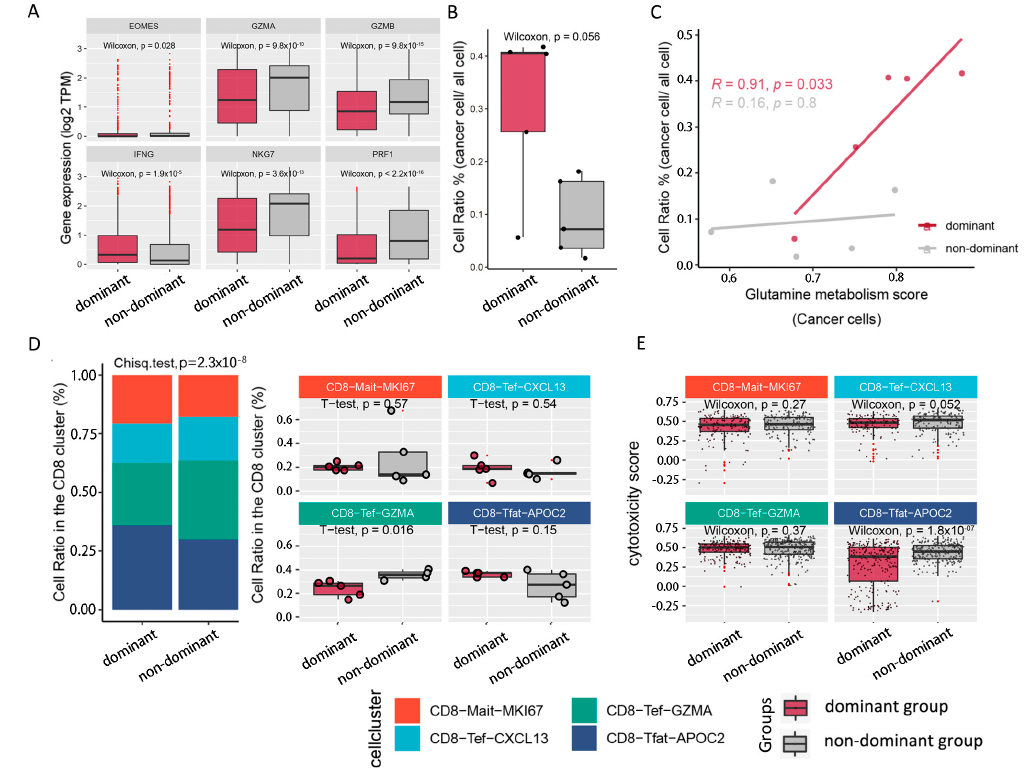
Figure 3. Differences in composition ratios and antitumor abilities in CD8T subpopulations. ( A ) Box plot showing the expressions of cytotoxicity-related genes (GZMA, GZMB, PRF1, IFNG, EOMES